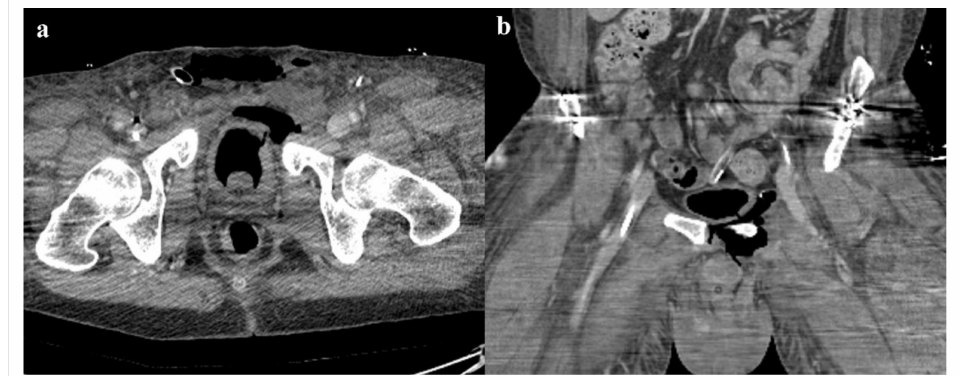
Figure 13. Patient of the Figure 6, with an extraperitoneal bladder rupture. The retrograde introduc- tion of air shows a leak at the level of the anterior wall ( a , b ). Urethral injuries are more common in men and are typically localized in the prostatic and membranous portions